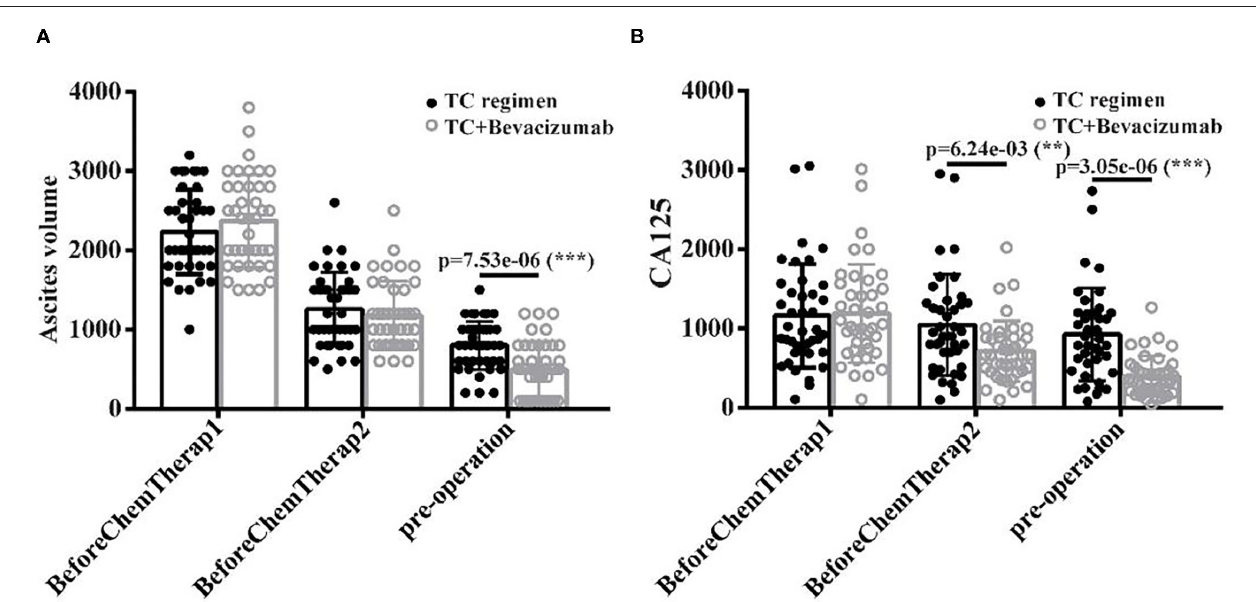
FIGURE 3 | (A,B) The level of ascites volume and CA125 after TC and TCB treatment in advanced ovarian cancer, ** P < 0.01, *** P < 0.001, vs. control group.